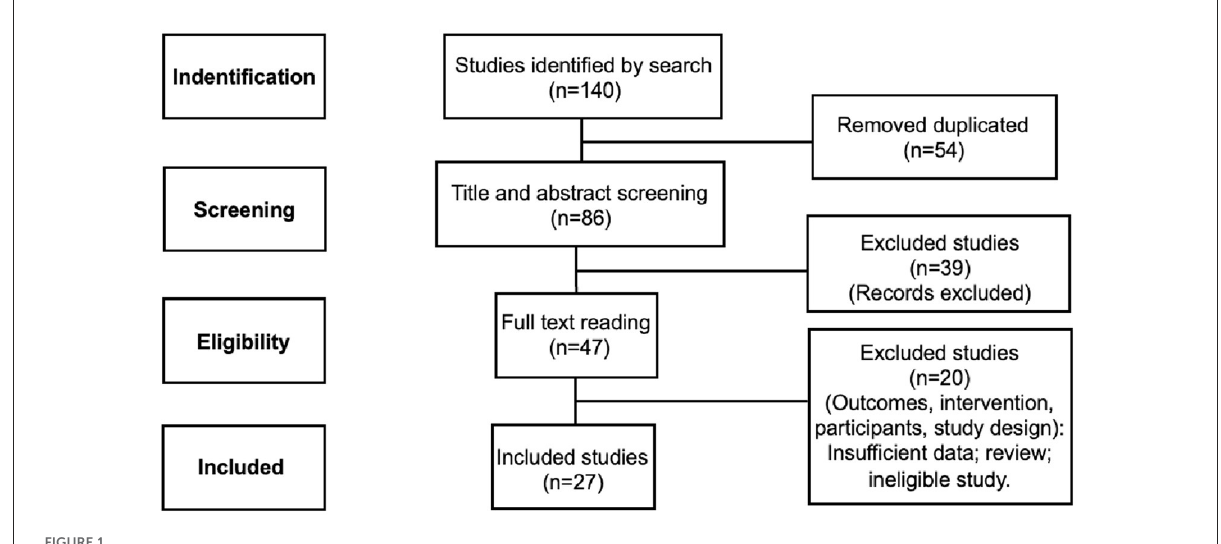
FIGURE1 Diagram of article selection